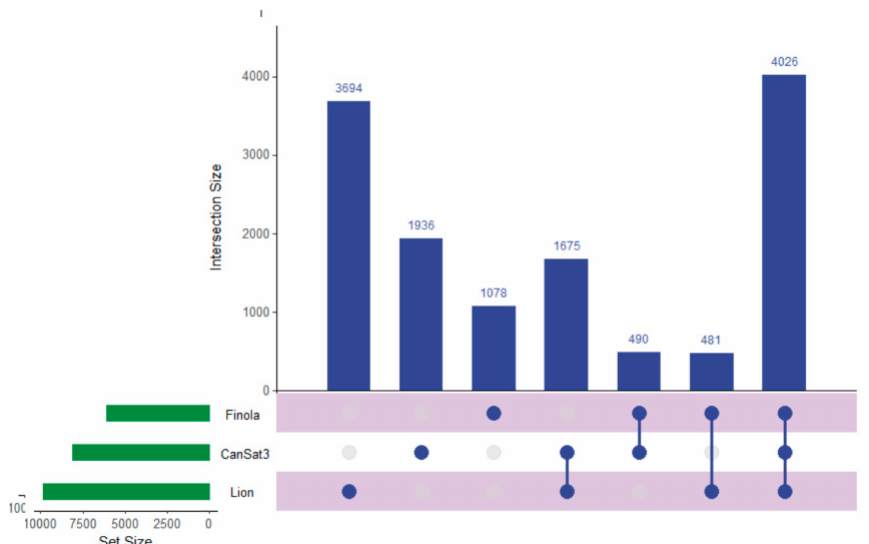
Figure 1. An UpSetR graph showing the unique protein identifications associated with each genomic dataset used for the generation of the proteogenomic FASTA as well as the number of proteins shared between the